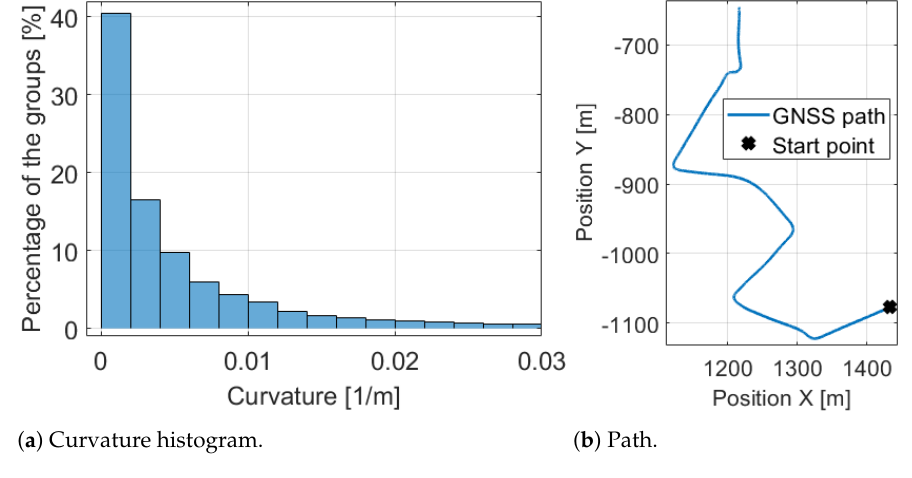
Figure 7. Path and its curvature histogram.